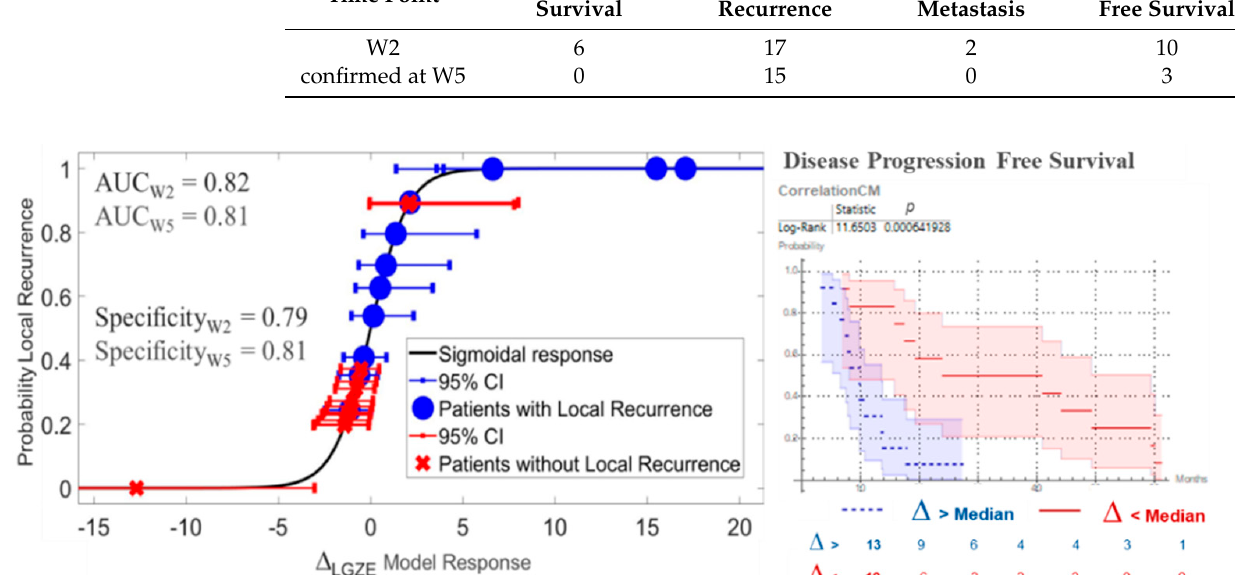
Figure 4. Prediction of treatment outcome by variations in low gray-level zone emphasis ( ∆ LGZE ) and by variations in the Table 3. Number of FMISO radiomic features able to predict treatment outcome. Benjamin– correlation of co-occurrence matrix ( ∆ C CM ). On the left, the model for prediction of local recurrence by ∆ LGZE at W5 is Hochberg multiple-test correction was applied to determine statistical significance. shown. On the right, Kaplan–Meier curves and log-rank test for prediction of disease progression free survival by ∆ C CM at W2 are shown. CI = Confidence